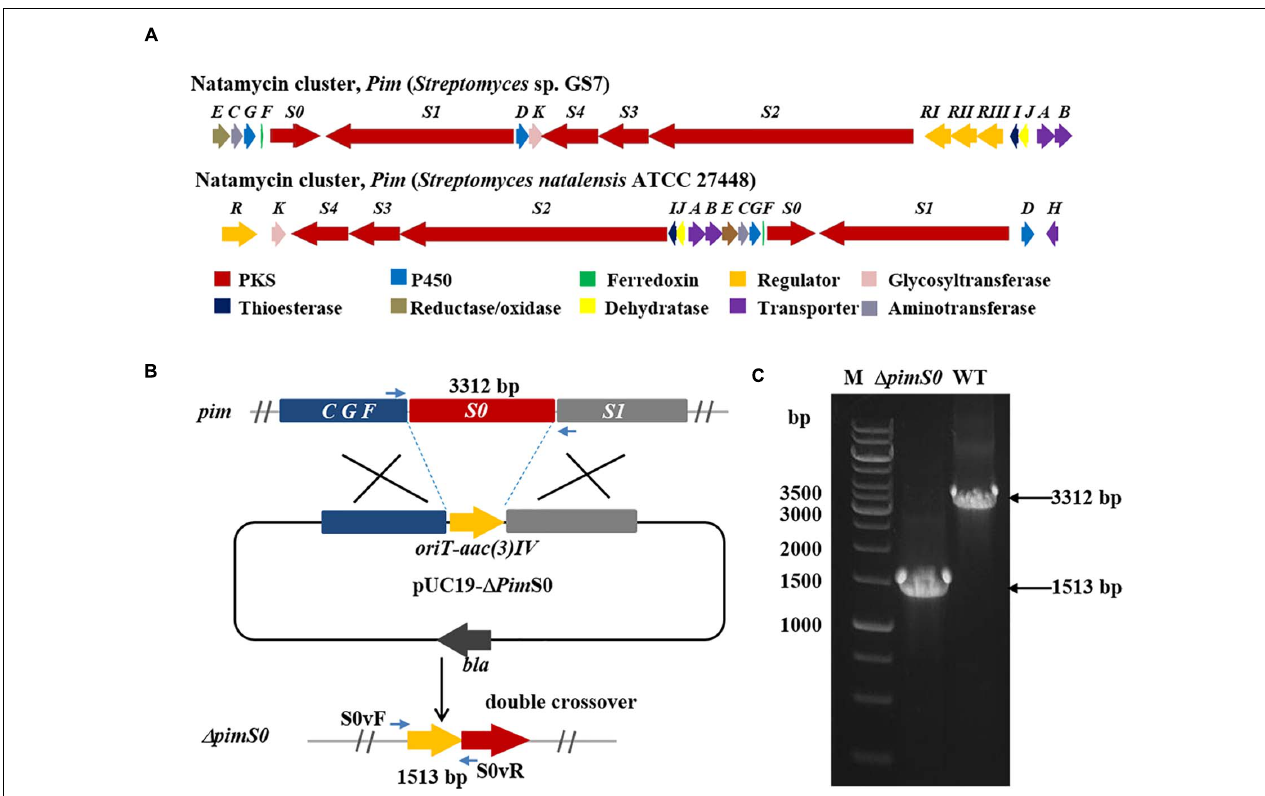
FIGURE 4 | Disruption of a key natamycin biosynthetic gene pimS0 in Streptomyces sp. GS7. (A) Comparison of the genetic organization of natamycin BGCs in Streptomyces sp. GS7 and S. natalensis ATCC 27448. (B) Schematic representation for disruption of pimS0 . (C) Verification of the pimS0 -disrupted mutant by PCR. M, DNA marker. The fragments were amplified using primers of